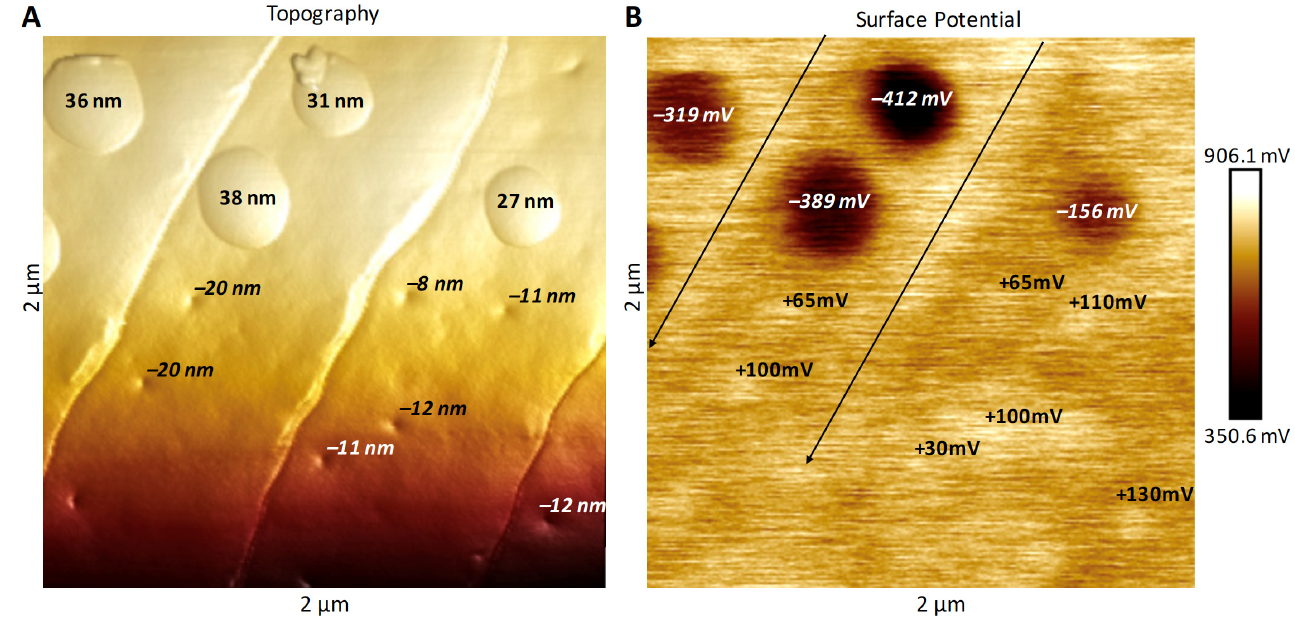
Figure 6. Surface potential measurements of a 2 µm × 2 µm section of a trichoid sensillum from Manduca sexta related to the topography of ridges, domes and pores on the same section. ( A ) AFM 3D topographical image showing heights of domes of domed pores and depths of open pores. Height/depth measurements were taken using the Nanoscope Analysis section tool. ( B ) Surface po- tentials of the same domed-pore domes and open pores shown in ( A ). Surface potential measurements were taken using the Nanoscope Analysis section tool. Note the domes have large negative potential readings relative to the background potentials of the neighboring flat planar regions, whereas open pores exhibit small positive potentials. The long black parallel arrows in ( B ) delineate small positive potentials running along the ridges.